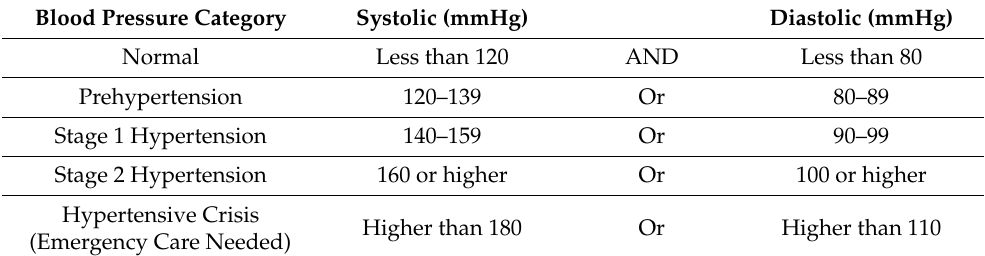
Table 2. Hypertension